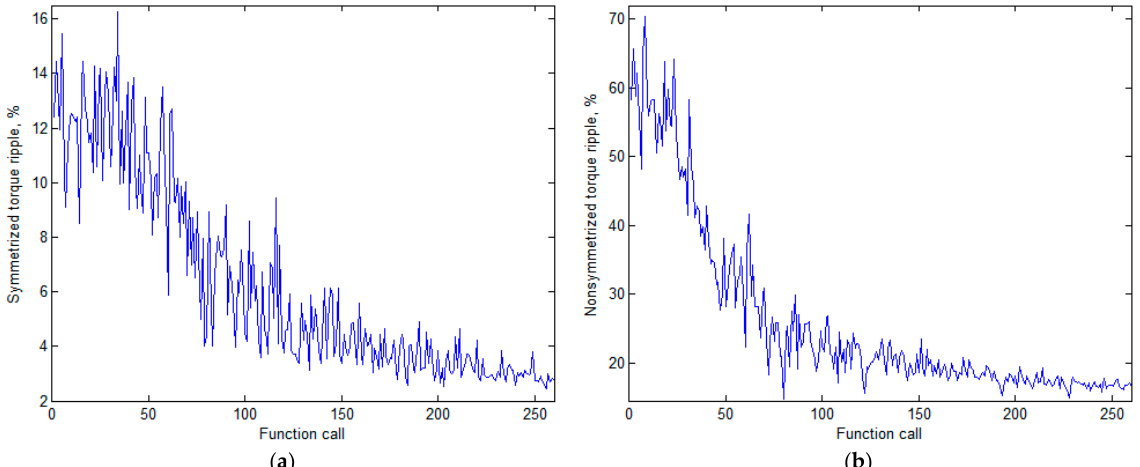
of the motor current.